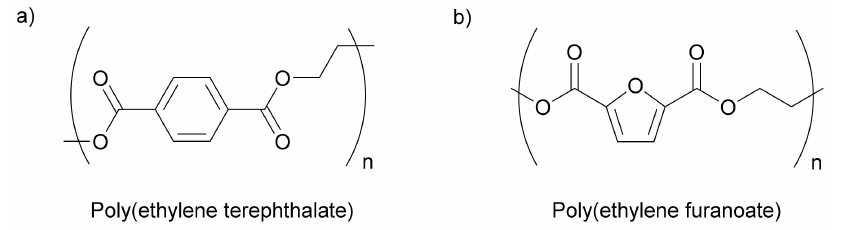
Figure 3. Chemical structure of ( a ) poly(ethylene terephthalate) (PET) and ( b ) poly(ethylene fura- noate)